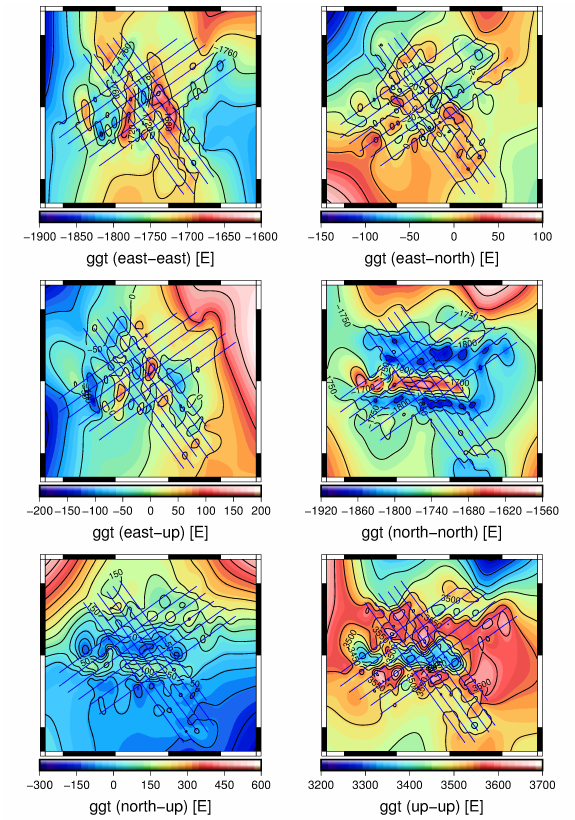
Figure 7: Superposition of 12 profiles with variations of gravity gradient tensor components.